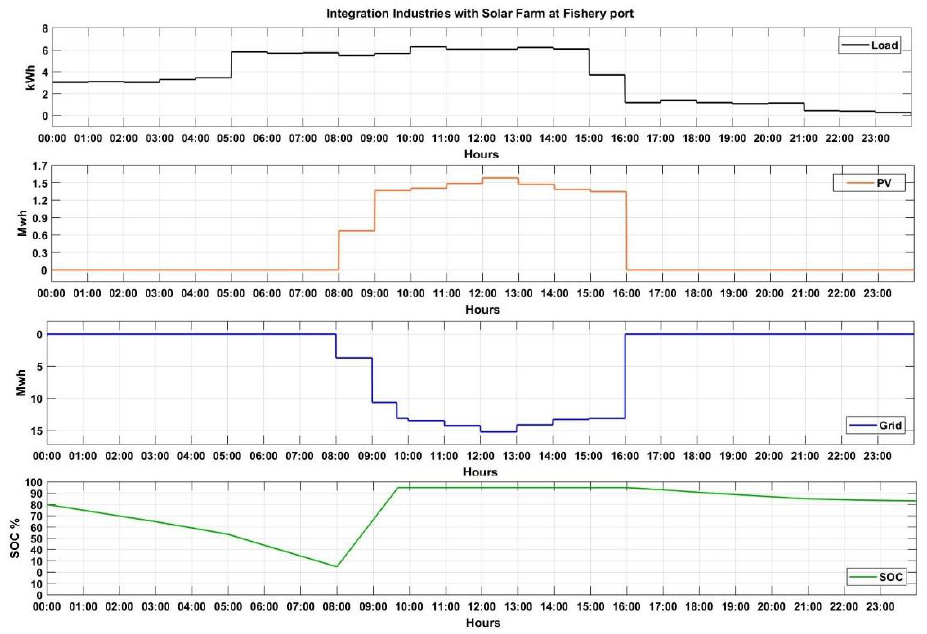
Figure 9. The simulation results when integrating industries with the solar farm.